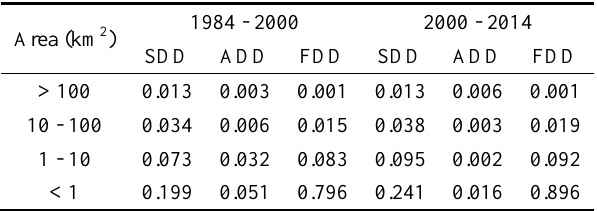
Table 5 "Swap - attenuation - fragmentation" dynamic evolution measurements of lakes in Jianghan Plain